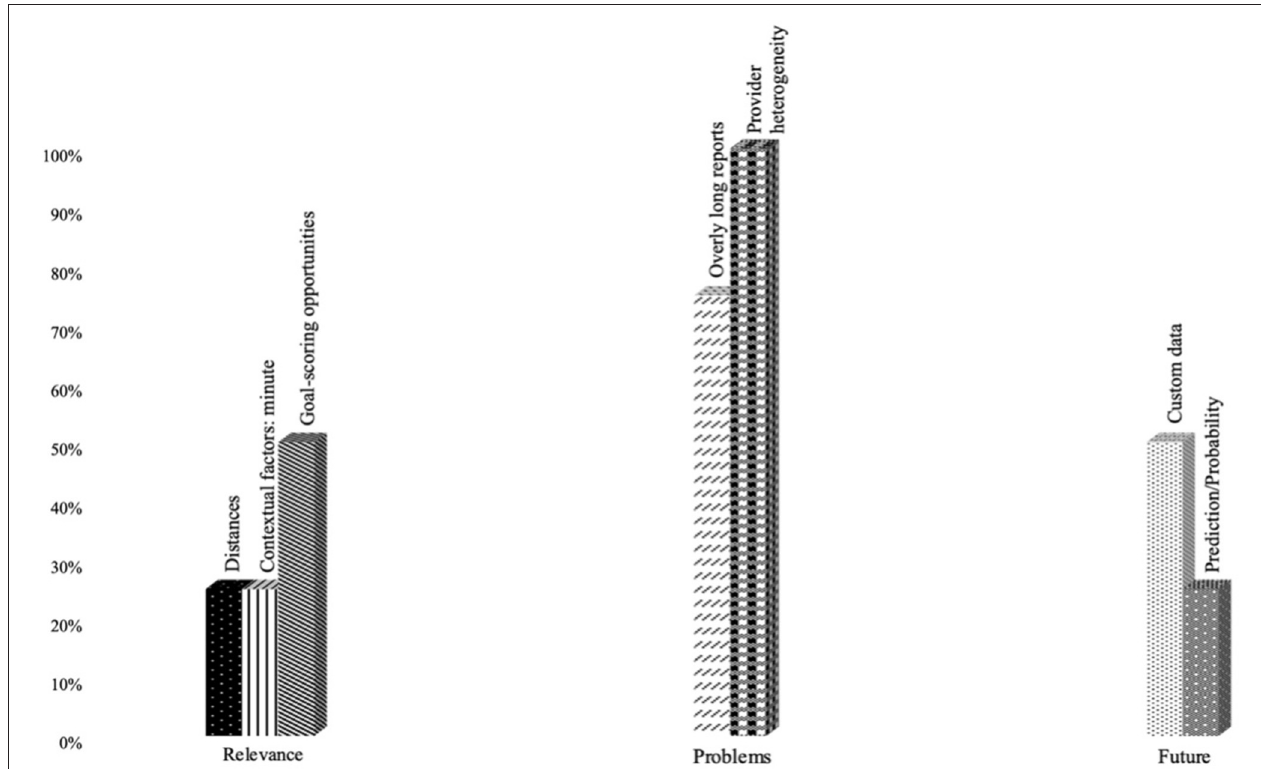
FIGURE 2 | Answer frequency to the question “Data provider